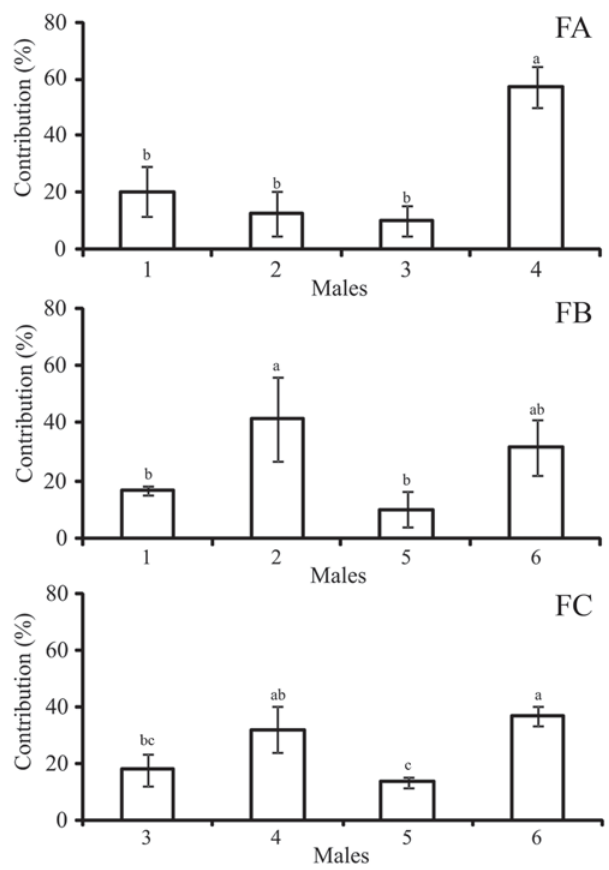
Fig. 1. Mean values and standard deviation of the relative contribution of each male to the progeny when the oocytes of each female (FA, FB, FC) were fertilized with pooled semen from four males (pool A: M1+M2+M3+M4; pool B: